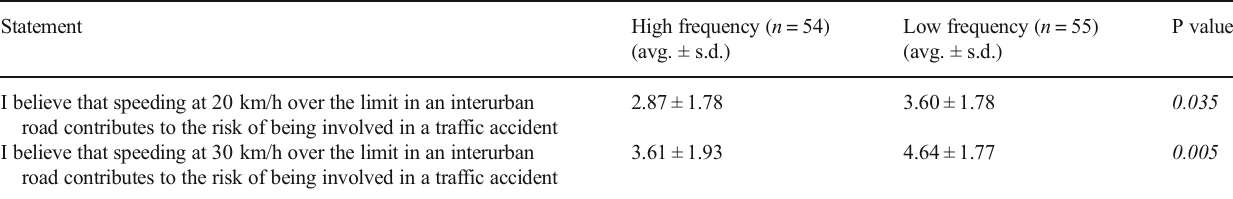
Perceived contribution of different causes to the risk of being involved in a car crash in relation to the frequency of speeding